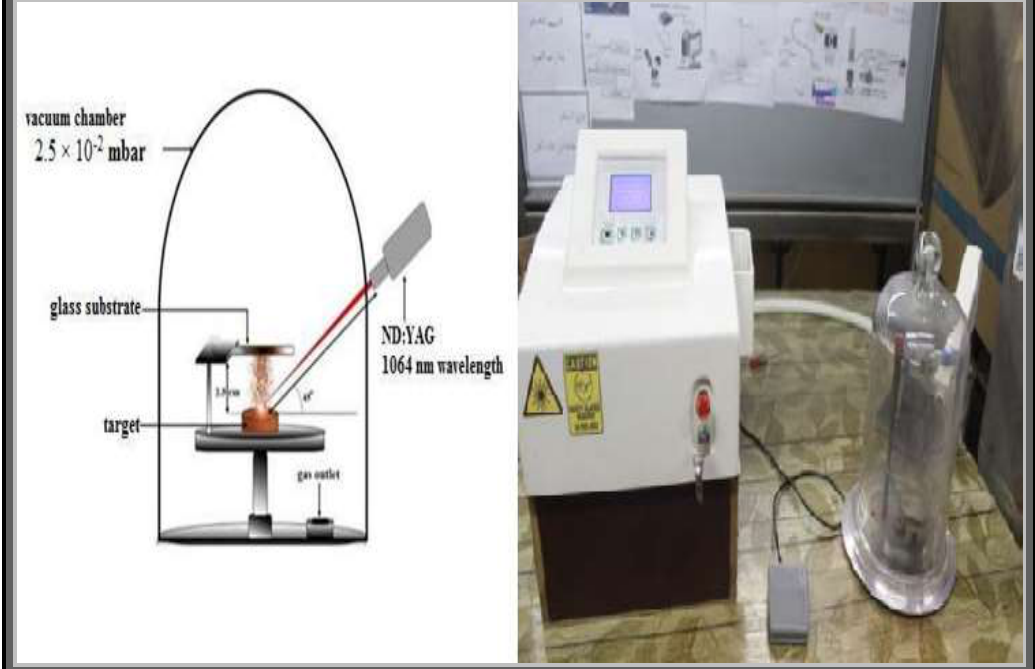
Fig. 1: Schematic diagram of pulsed laser deposition